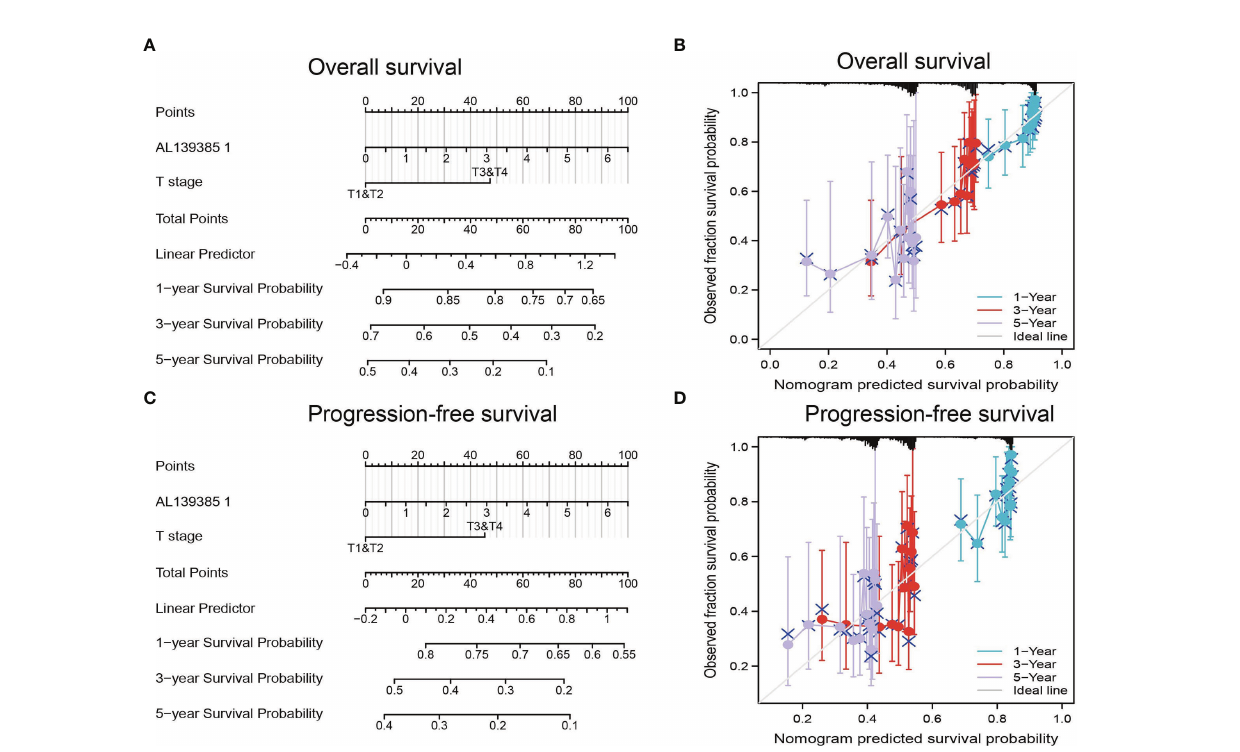
FIGURE 4 | Construction and performance validation of the AL139385.1-based nomogram for lung adenocarcinoma patients. (A – D) Nomogram to predict the overall survival and progression-free survival for lung cancer patient, the calibration curve, and Hosmer – Lemeshow test of nomograms in the TCGA lung adenocarcinoma cohort for overall survival and progression-free